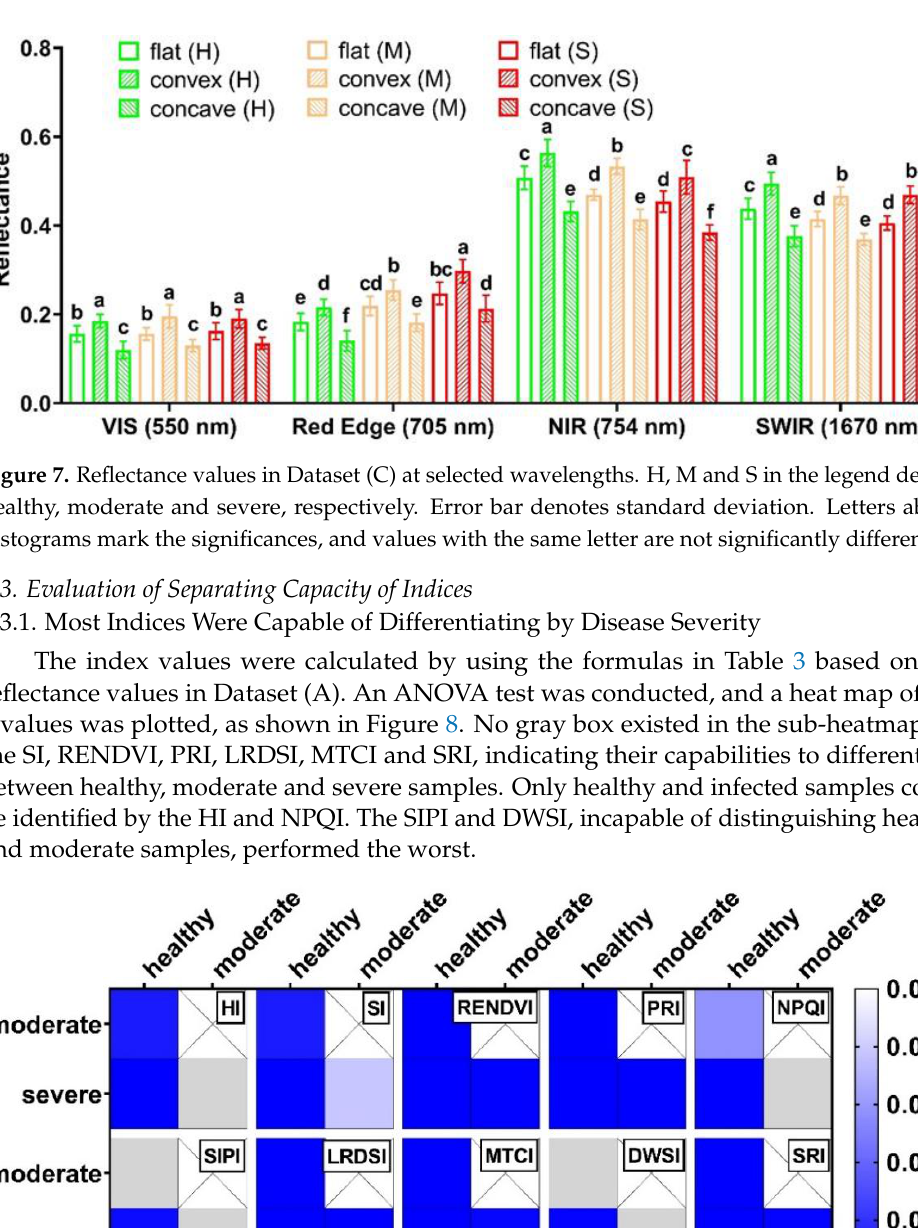
Figure 9. Heat map of p values for different indices calculated based on Dataset (B). H, M and S in x and y axis denote healthy, moderate and severe, respectively. Cross means no data, and gray box means not significant. 3.3.3. All indices Were Affected by Leaf Curvature to Varying Degrees except PRI The same processing as described in Section 3.3.1 was carried out based on the spec- tra in Dataset (C), and the heat map is shown in Figure 10. The PRI outperformed all the other indices, as the PRI was not sensitive to the leaf curvature at any disease severity level (i.e., the nine gray boxes in the sub-heatmap for the PRI). Moreover, the disease se- verities could be identified perfectly by the PRI whether the leaves were flat or not (i.e., dark blue boxes in the sub-heatmap of the PRI). The RENDVI, LRDSI, MTCI and SRI